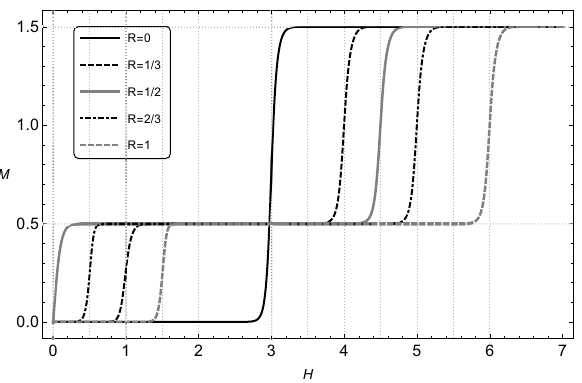
Figure 2. Magnetization of the one-dimensional Ising model with nearest-neighbor and next-nearest-neighbor antiferromag- netic interactions with s = 3 / 2 at T = 0 . 05 for five di ff erent val- ues of parameter R = J 2 / J